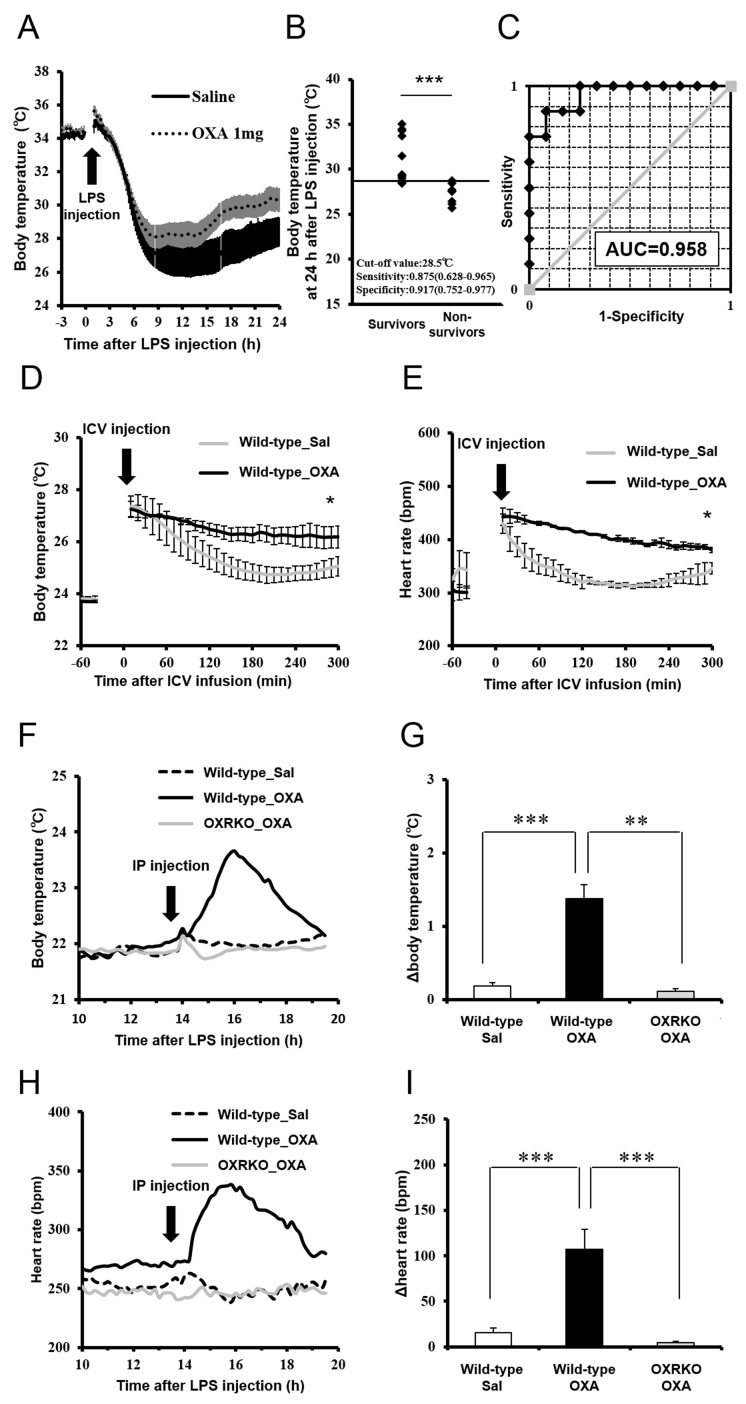
Effects of OXA on body temperature and heart rate in mice with endotoxin shock.(A) The changes in body temperature of LPS-injected mice treated with OXA (1 mg/mouse/24 hr) or saline (each group n = 10). (B) The correlation between the survival and body temperature in mice with endotoxin shock (Survivor n = 12, Non-survivor n = 8, ***p<0.001). (C) Receiver operating characteristic (ROC) curve between survival and body temperature in mice with endotoxin shock. AUC: area under the curve. (D, E) Transient effects of bolus ICV-injected OXA (Wild-type_OXA) or saline (Wild-type_Sal) on body temperature (D) and heart rate (E) in LPS-injected wild-type mice (each group n = 4, *p<0.05). (F, H) Transient effects of bolus IP-injected OXA on body temperature (F) and heart rate (H) in mice with endotoxin shock. (G, I) IP injection of OXA (Wild-type_OXA) but not saline (Wild-type_Sal) increased body temperature (G) and heart rate (I) transiently in LPS-injected wild-type mice, but not in LPS-injected OXRKO mice (OXRKO_OXA) (each group n = 4, **p<0.01, ***p<0.001). Statistical significance assessed by unpaired t-test (B), 2-way ANOVA (D, E), and 1-way ANOVA coupled with the Bonferroni’s test (G, I). Data are replicated in at least three independent experiments.